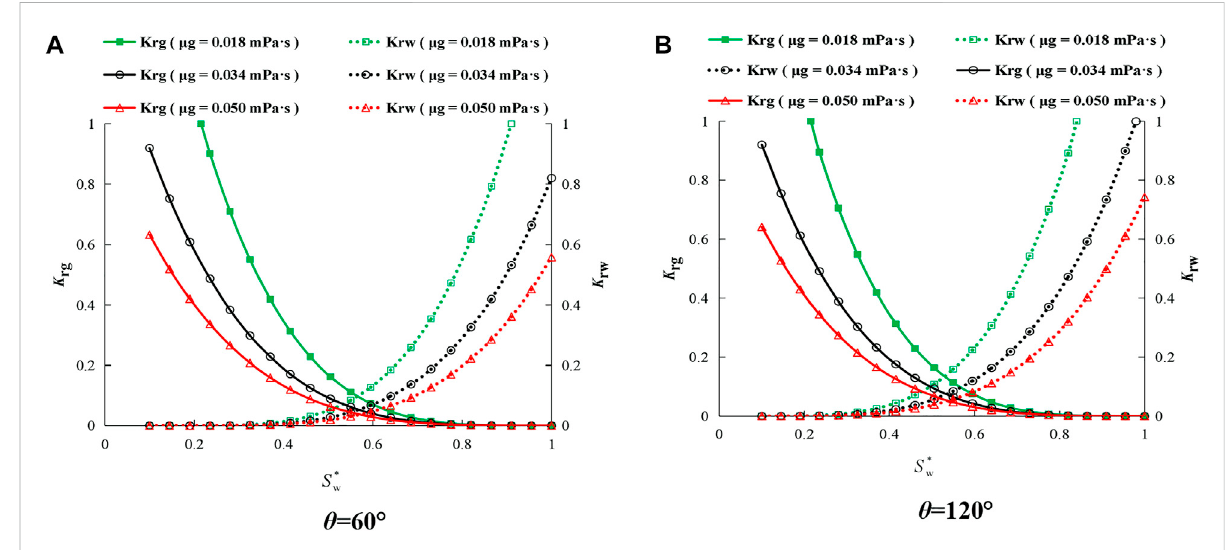
Effect of natural gas viscosity on the two-phase relative permeability.